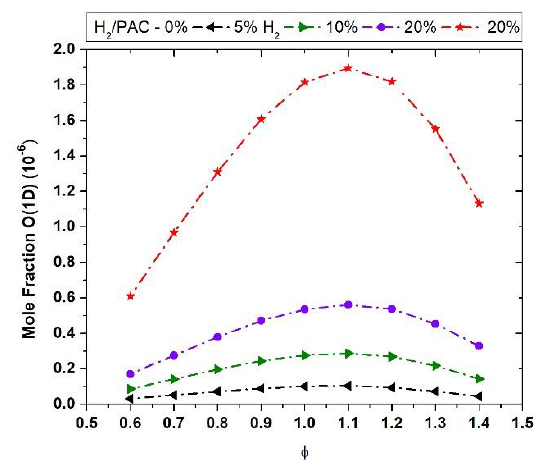
Figure 9. Comparison of atomic excited species O(1D) at various equivalence ratios using different H 2 contents with NSPD.